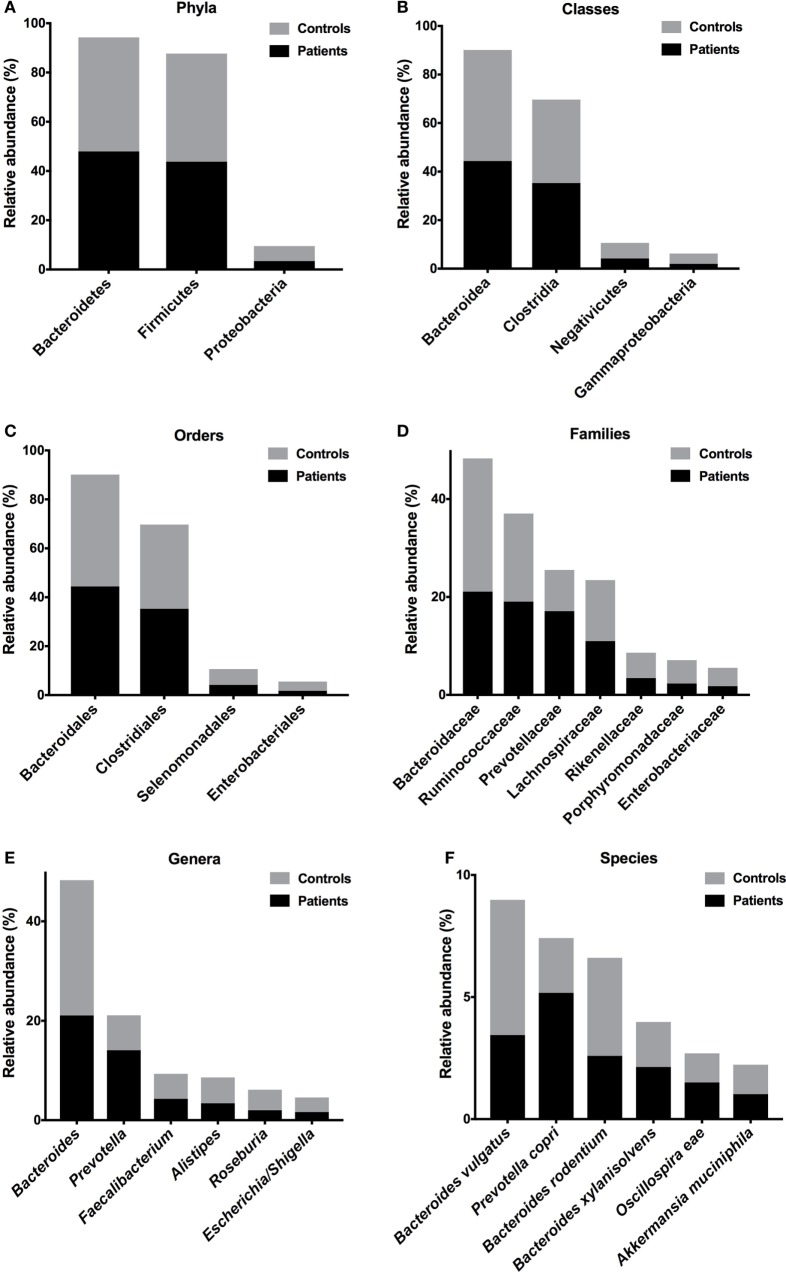
Relative abundances of bacterial taxa in the feces of T2D patients. Prevalent phyla (A), classes (B), orders (C), families (D), genera (E), and species (F). Bars represent the reads percentages found in metagenomic analyses.